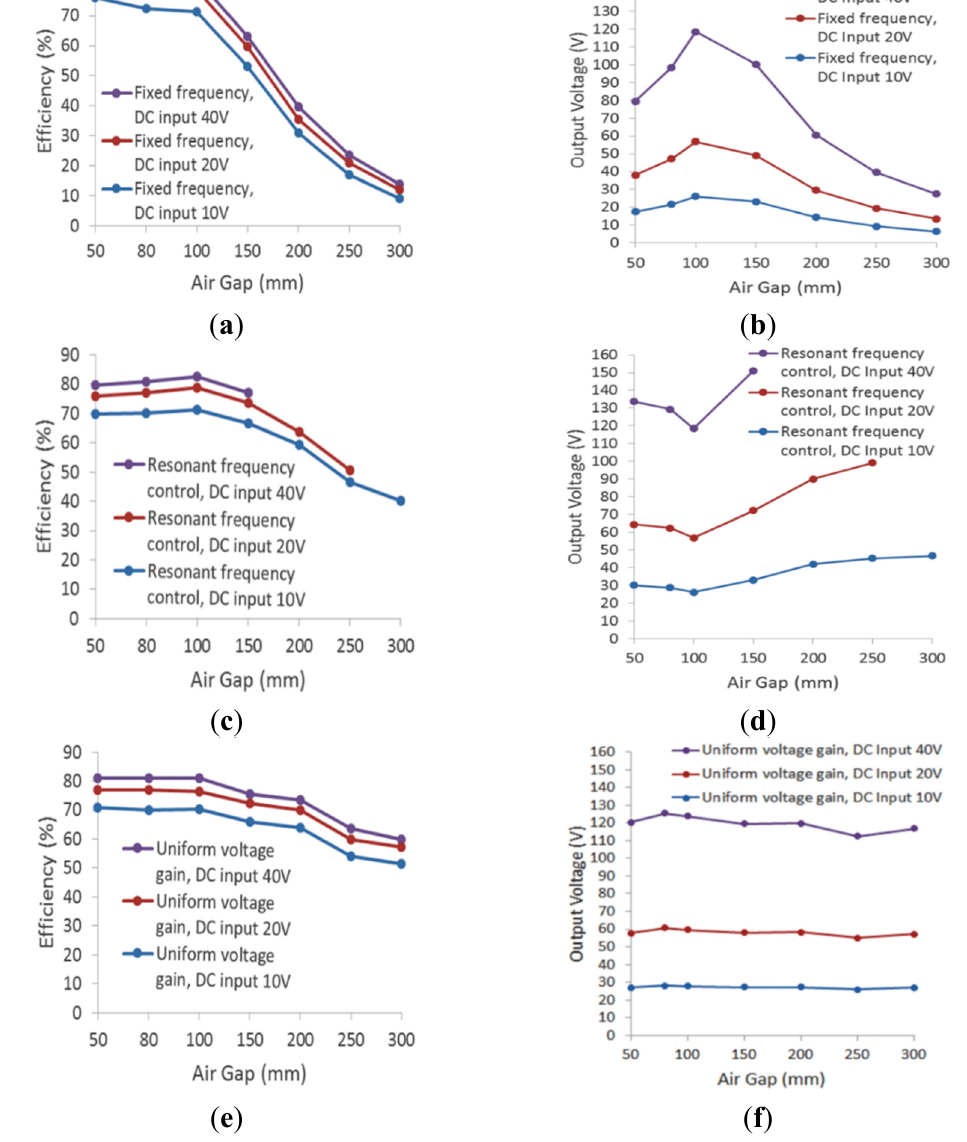
Figure 8. Experimental comparison in three control modes with different air gaps and no coil misalignment. ( a ) Efficiency at a fixed frequency; ( b ) Voltage at a fixed frequency; ( c ) Efficiency at resonant frequencies (phase angle θ = 0); ( d ) Voltage at resonant frequencies (phase angle θ = 0); ( e ) Efficiency at uniform gain frequencies; and ( f ) Voltage at uniform gain